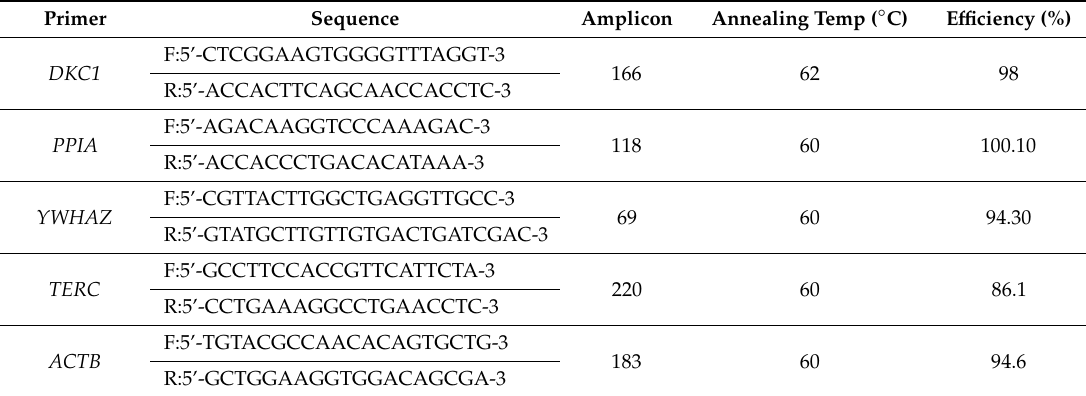
Table 2. Primer sequences used for qPCR